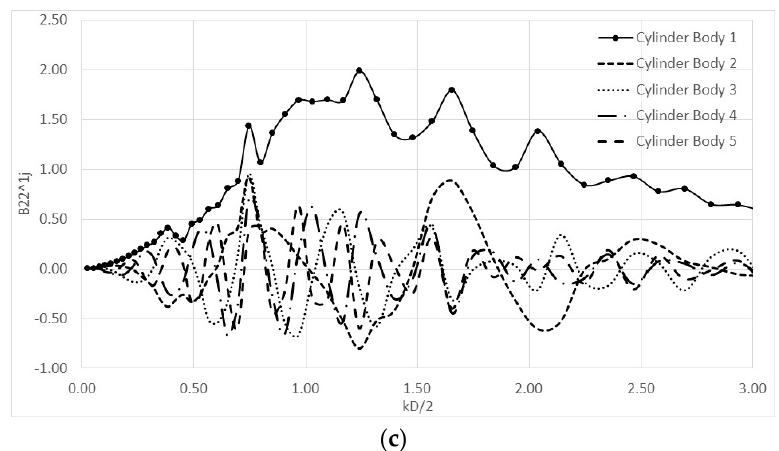
Figure 22. Dimensionless damping coefficient of the 1st floater at the sway direction due to the forced motion in sway of the j- th floater ( j = 1, 2, …, 5) against kD/2, for the three different examined types of floaters: ( a ) conical floater; ( b ) semi-spherical floater; ( c ) cylindrical floater in the parallel array case configuration, C 1 .